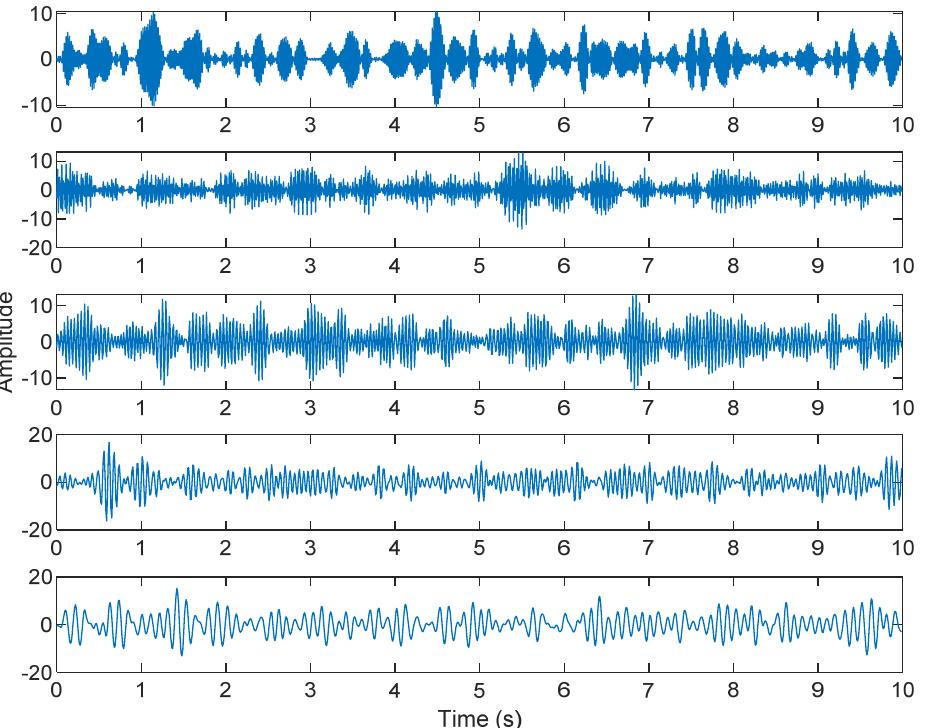
Sensors 2021 , 21 , x FOR PEER REVIEW Figure 3. The results of the VMD component obtained from the numerical simulation of the sensor.